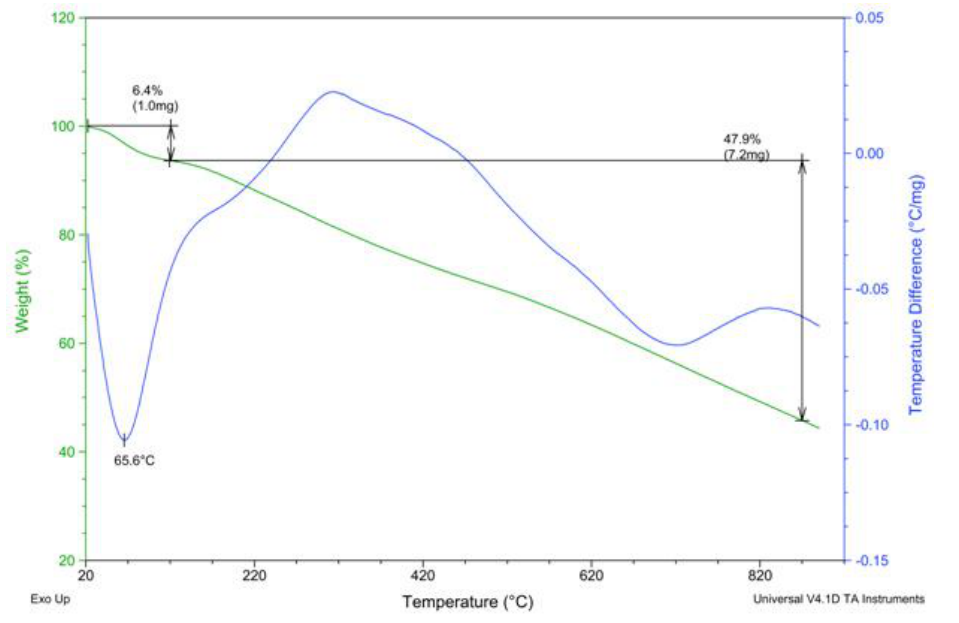
Figure 8. TGA and DTA analysis of the powders of PAPy with DP = 7 (left panel) and DP = 64 (right panel) at a heating rate of 10 °C·min − 1 in